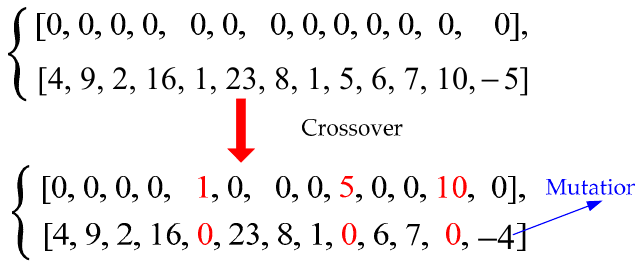
Figure 6. Examples of crossover operation for the sample chromosomes of the above example.